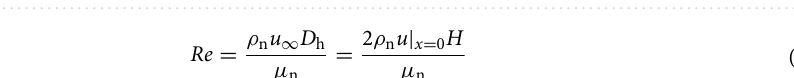
Figure 2. The overall